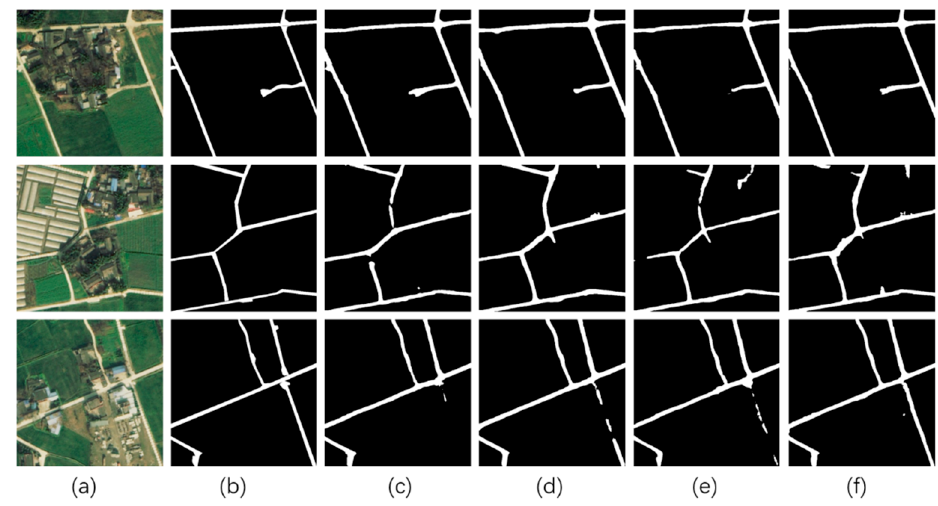
Remote Sens. 2022 , 14 , x FOR PEER REVIEW 19 of 25 Figure 20. Low-grade road extraction in general scene images ( a ) input image; ( b ) label image; ( c ) D-LinkNet; ( d ) S-DenseNet; ( e ) SD-DenseNet; ( f ) SDG-DenseNet.